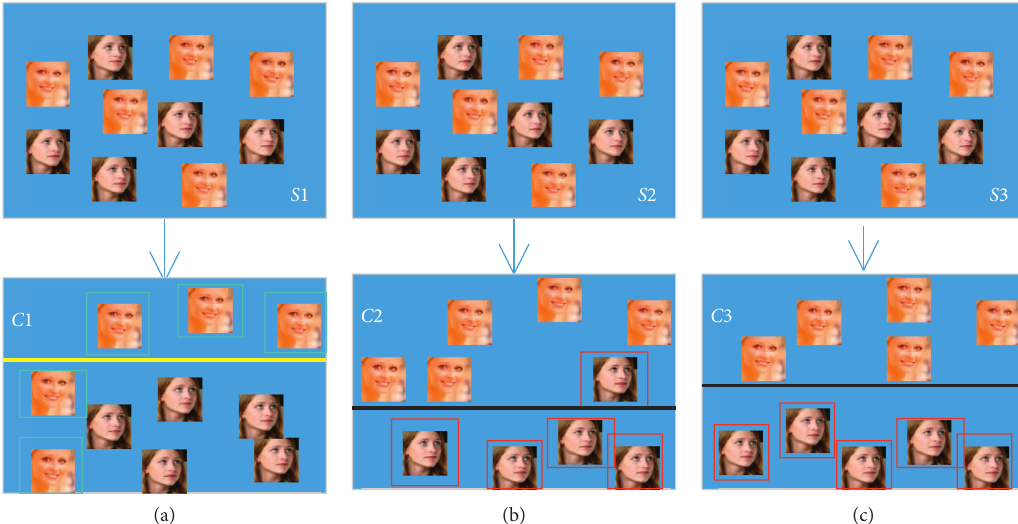
Figure 1: Schematic diagram of Adaboost algorithm. (a) The first step of classification. (b) The second step of classification. (c) The third step of classification.